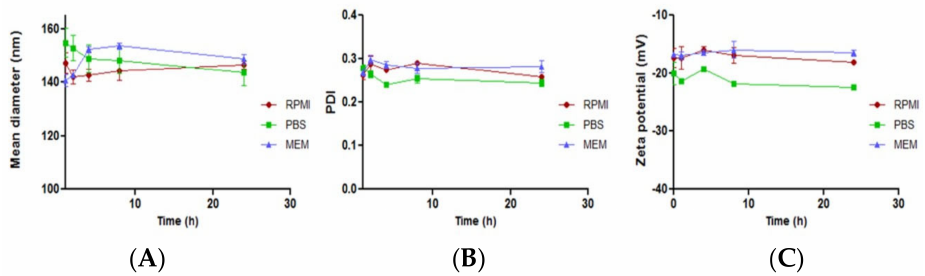
Figure 4. Effect on the ( A ) particle size, ( B ) PDI, and ( C ) zeta-potential of LPNP-TS-DOX after incubation in PBS (green line), RPMI (red line), and MEM (blue line), up to 24 h, at 37 ◦ C. Results are shown by the mean ± standard deviation (n =